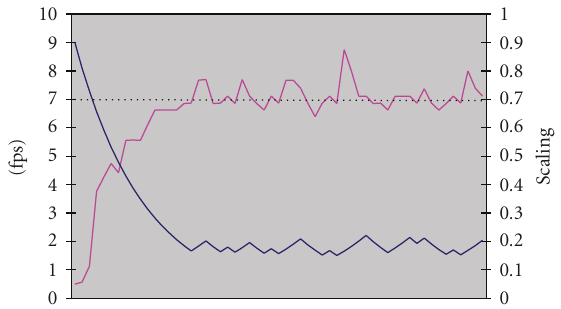
Figure 12: Pink line: frame rate in frames per second (fps). Blue line: view resolution scaling. The horizontal axis represents the